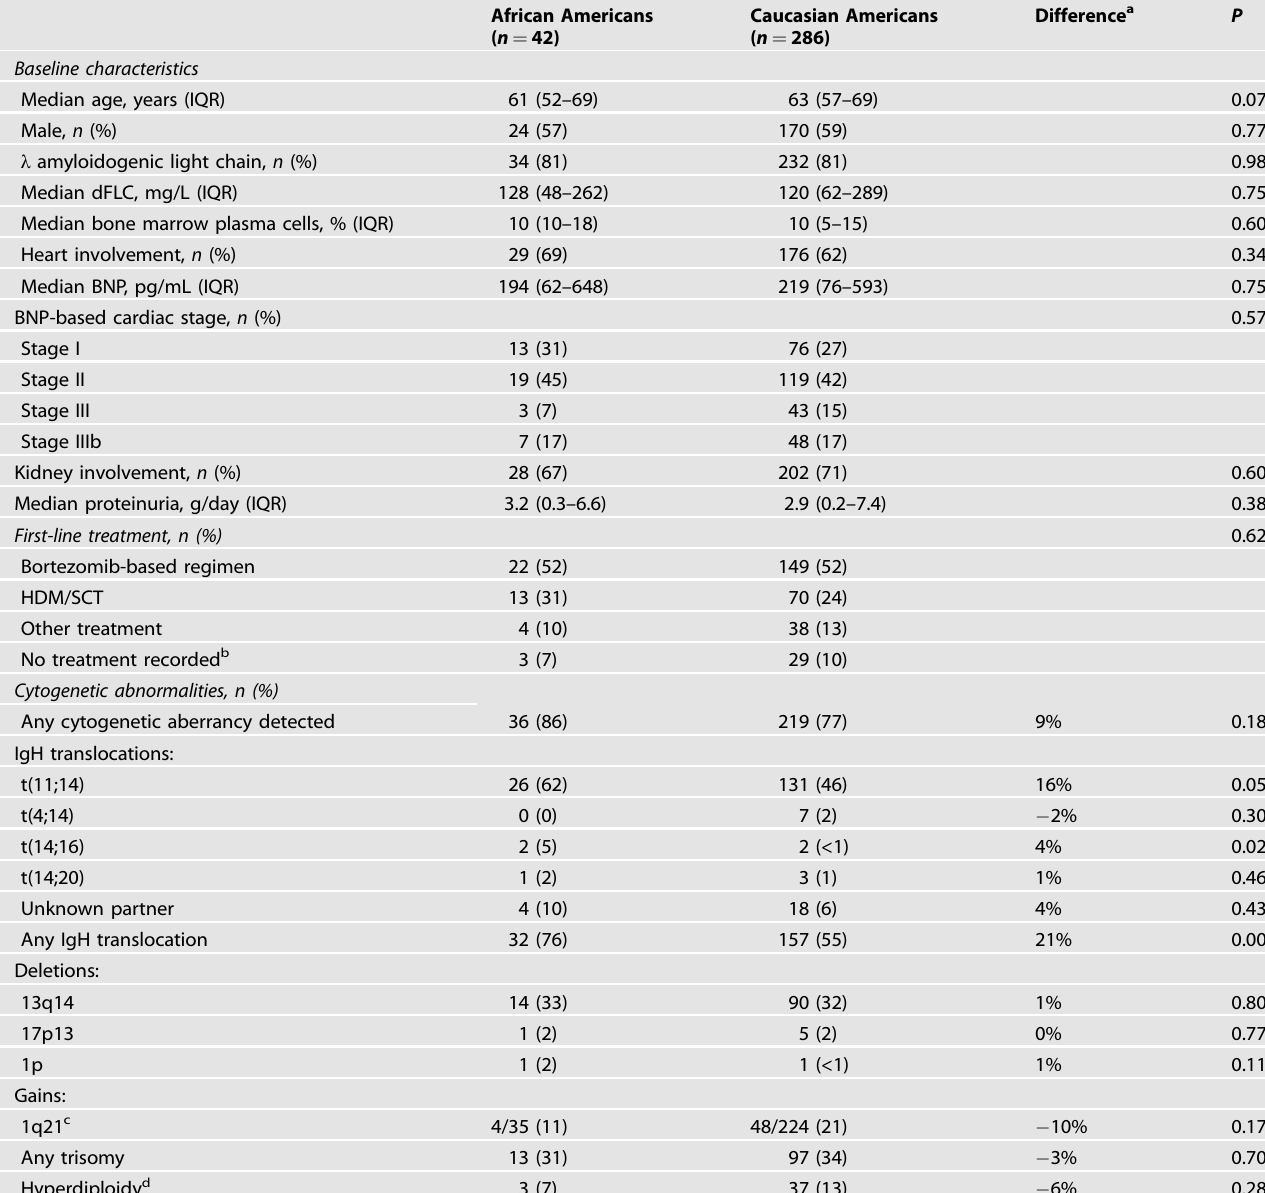
Table 1. Baseline characteristics and frequencies of chromosomal abnormalities in systemic AL amyloidosis according to self-identi fi ed racial